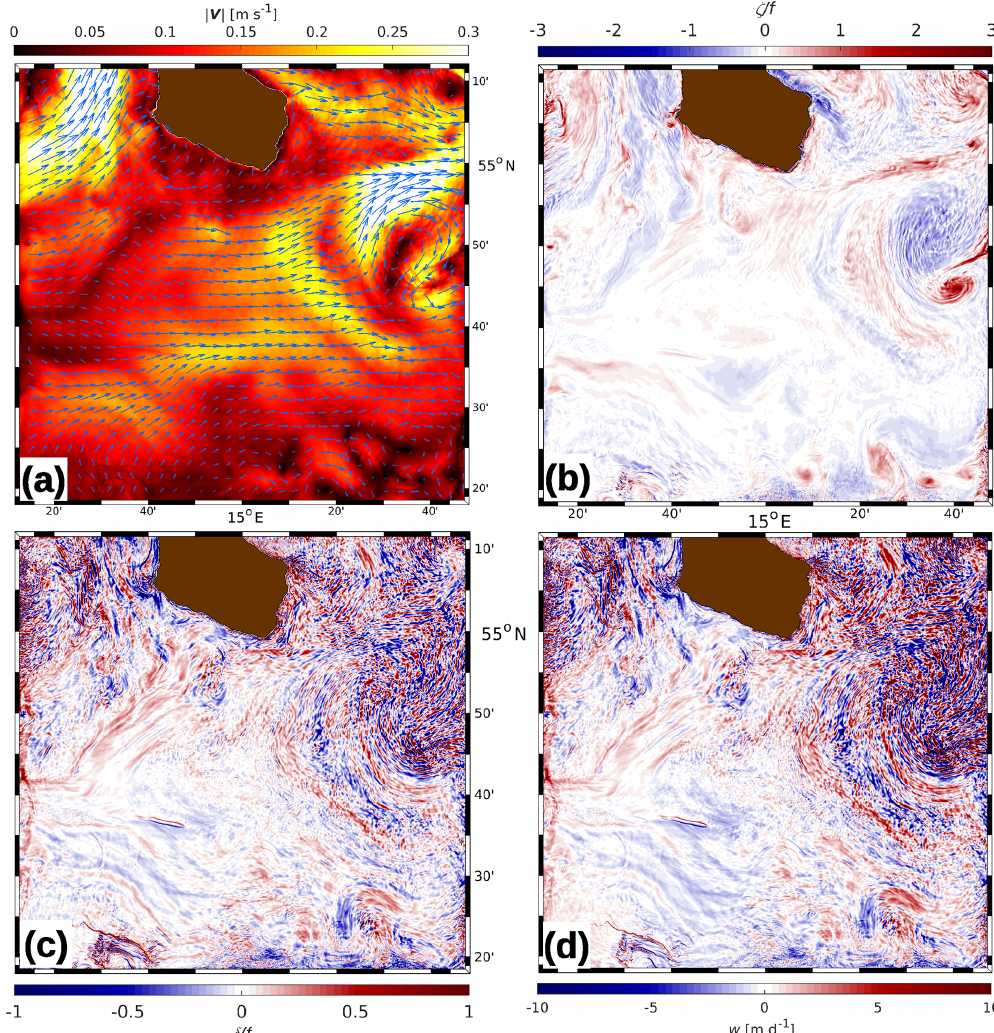
Figure 10. R100 with full atmospheric forcing on 26 June: (a) magnitude and direction of top-layer horizontal velocity V (vectors are plotted at 3km resolution), (b) relative vorticity ζ and (c) horizontal divergence δ , each scaled by f , (d) vertical velocity w at 5m of depth. For all subplots, the same colour scaling was used as in Fig. 7.